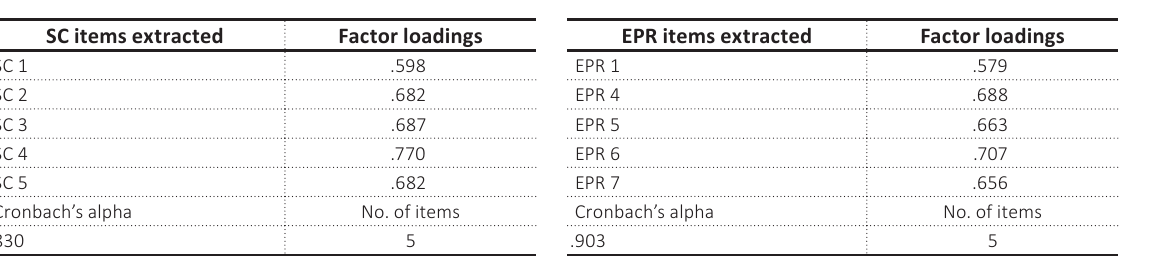
Table 6. Factor: Standpoints Considered when